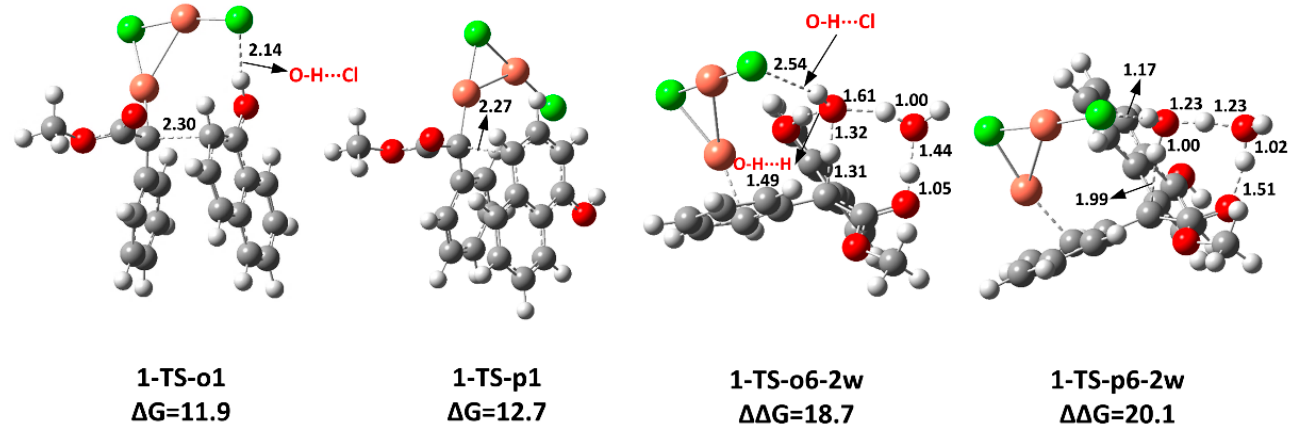
Figure 3. Optimized geometries of four transition states 1-TS-1o , 1-TS-1p , 1-TS-6-2w , and 1-TS-p6-2w corresponding to Figure 2. The distances are in the units of angstroms and the values of free energy barriers are in kcal mol − 1 .